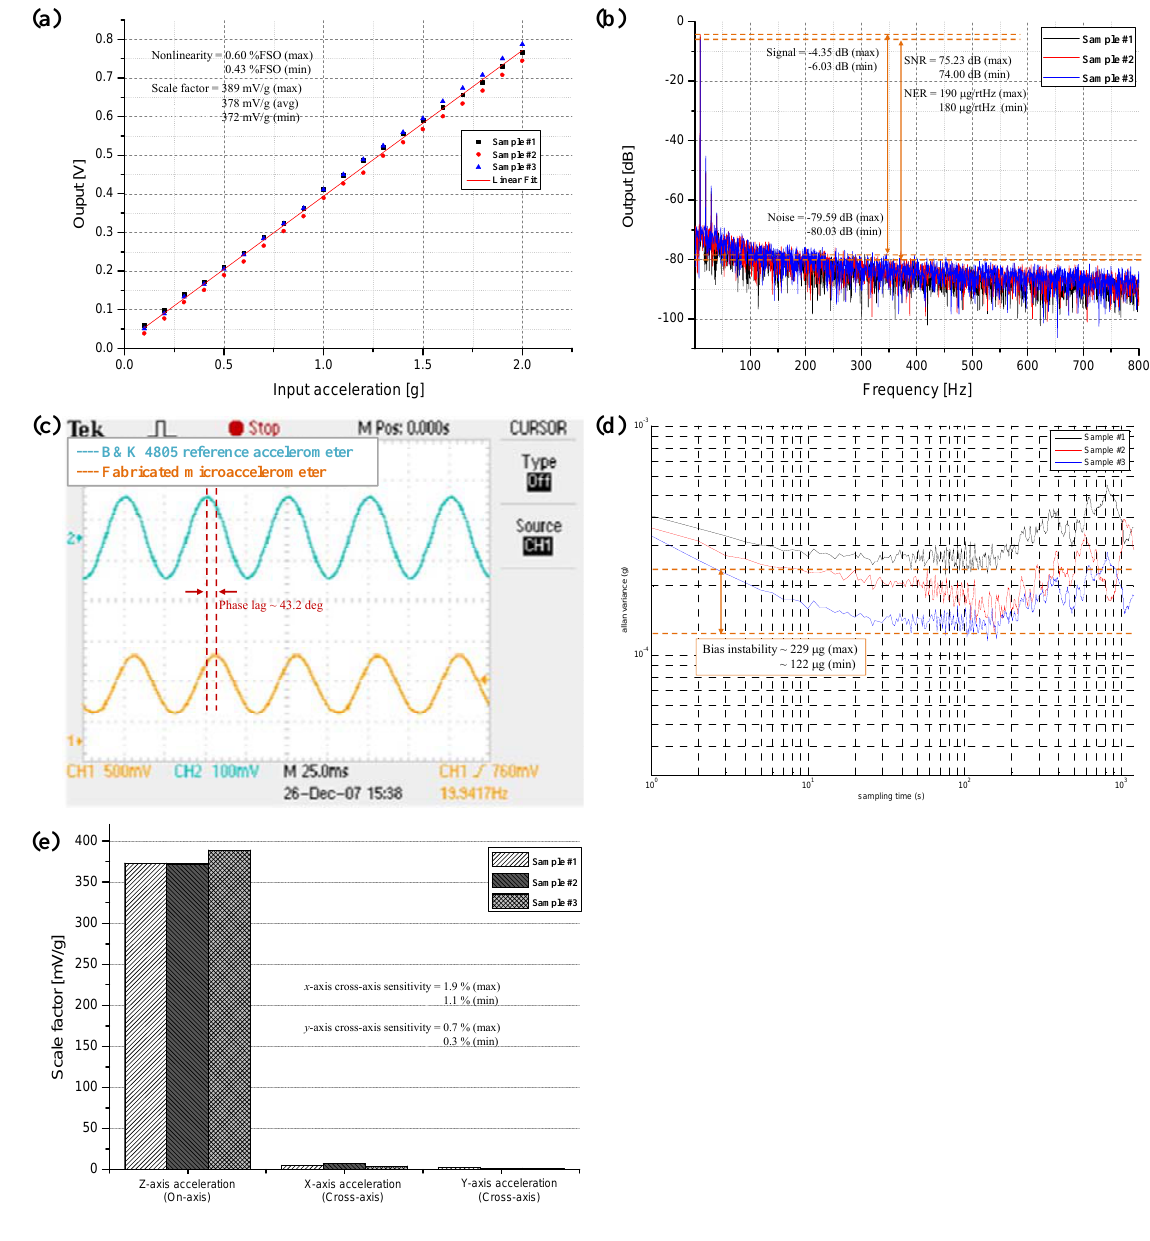
. Figure 16. (a) Input-output characteristics at 10 Hz input acceleration. (b) Output spectrum at 10 Hz, 1 g input acceleration. (c) Time-domain output of Sample #1 at 20 Hz, 1g input acceleration. (d) Bias instability (Root-Allan variance plot). (e) Cross-axis sensitivity. Performance evaluations of out-of-plane microaccelerometer